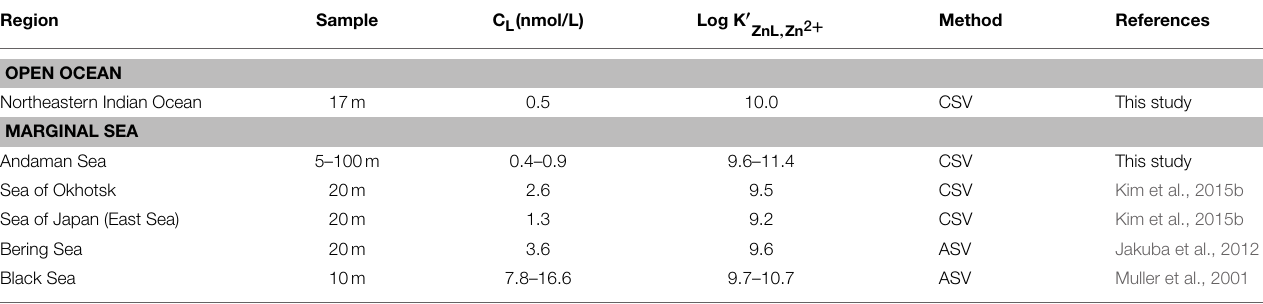
TABLE 2 | Zn complexation data from other relevant seawater studies.